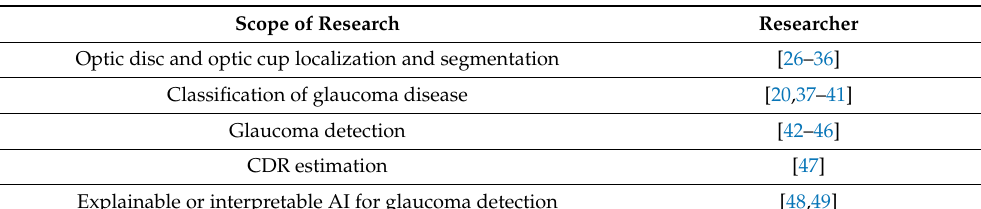
Table 2. Recent studies in using ORIGA-light dataset.